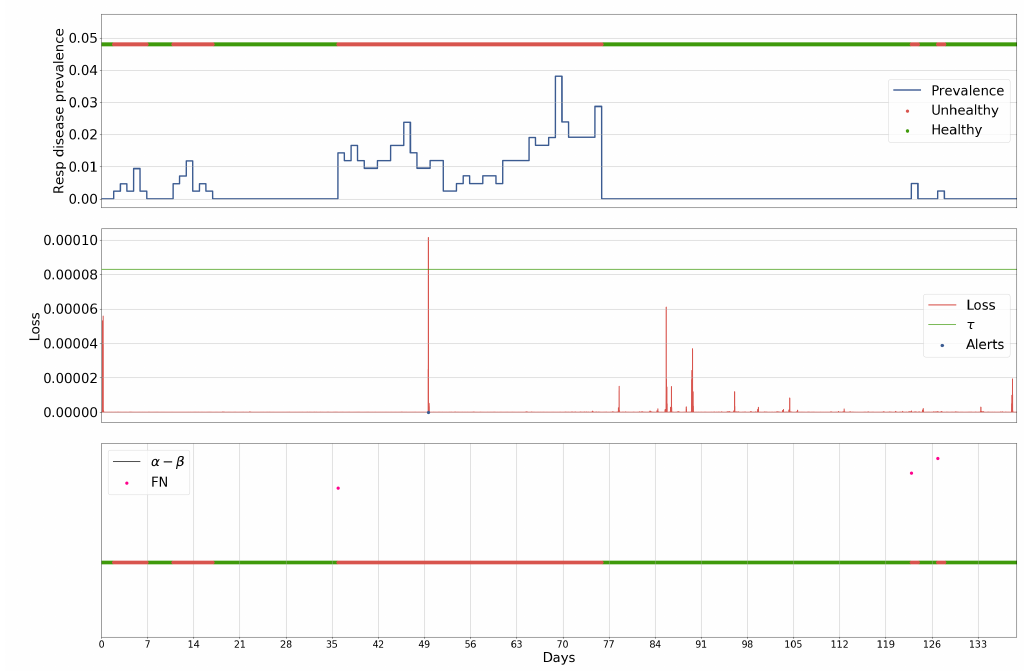
Figure 7. Results for batch 27 processed by the ARIMA-powered anomaly detection, given its grid search-optimised parameters α (the start of the window for which an alert is for), β (the length of the window), and τ (the threshold which the loss between predicted values and actual values must cross to be considered an alert), in relation to the prevalence of respiratory disease within a single